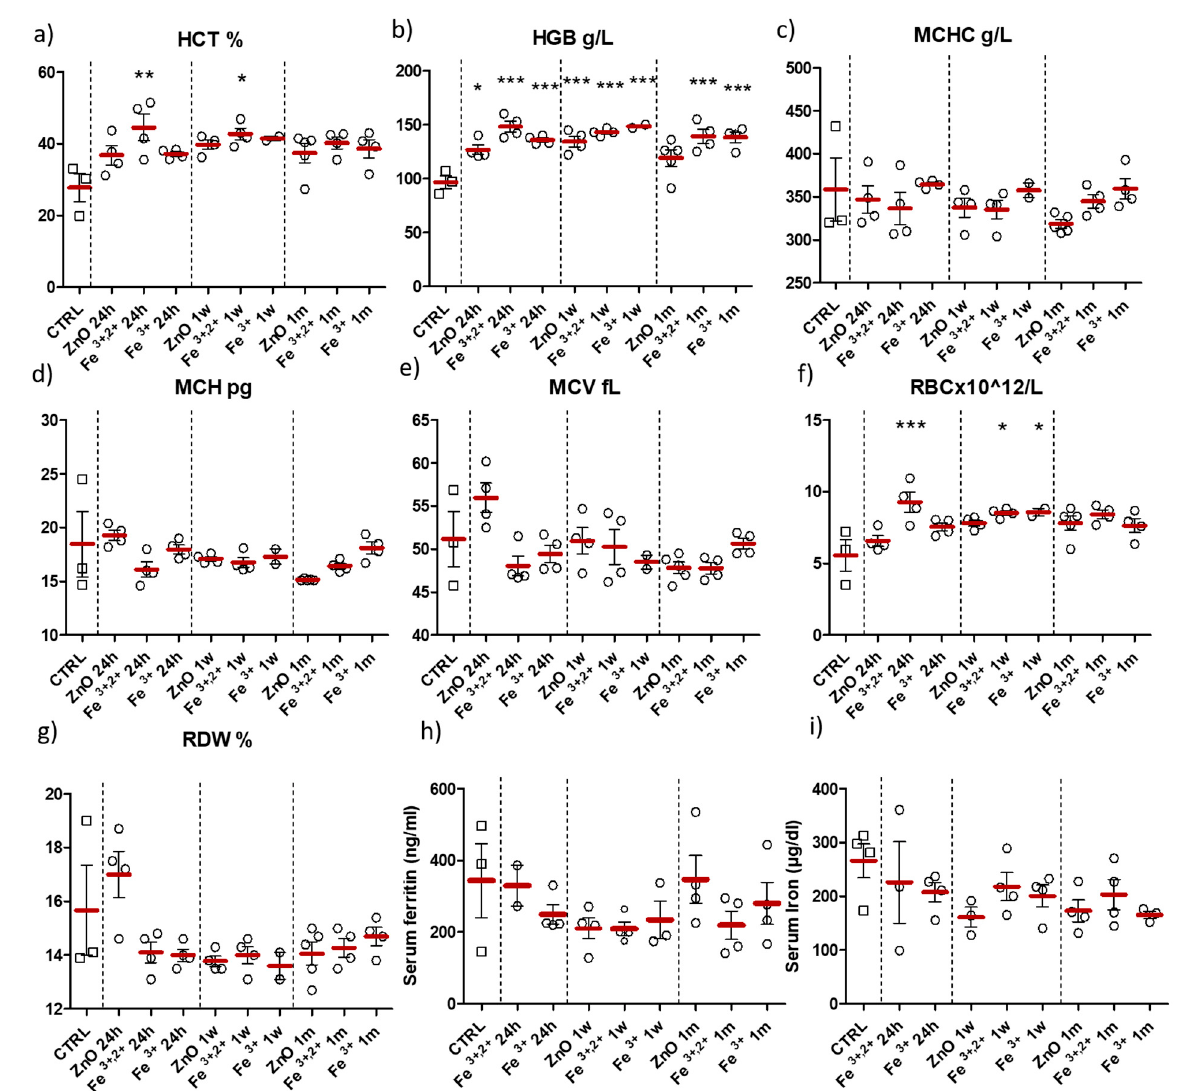
Figure 8. Hematological parameters, serum ferritin and iron levels in analyzed blood samples after intra-gastric administration (gavage) of ZnO, ZnO:Fe 3+ or ZnO:Fe 3+,2+ nanoparticle suspension in RO water vs. the control group (CTRL). Animals were sacrificed following 24 h, 1 week (1 w) or 1 month (1 m) after nanoparticle application. Hematocrit-HCT ( a ), hemoglobin concentration-HGB ( b ), mean corpuscular hemoglobin concentration-MCHC ( c ), mean corpuscular hemoglobin-MCH ( d ), mean corpuscular volume-MCV ( e ), erythrocyte count-RBC ( f ), red cell distribution width-RDW ( g ), serum ferritin ( h ) and iron ( i ) levels were measured in mice blood. Data presented as mean (±SEM) for control ( n = 3 for a – h / n = 4 for i ) vs. experimental groups (ZnO 24 h n = 4; Fe 3+,2+ 24 h n = 4; Fe 3+ 24 h n = 4; ZnO 1 w n = 4; Fe 3+,2+ 1 w n = 4; Fe 3+ 1 w n = 2–4; ZnO 1 m n = 5; Fe 3+,2+ 1 m n = 4; Fe 3+ 1 m n = 4). Statistically significant differences of * p ≤ 0.05, ** p ≤ 0.01, and *** p ≤ 0.001 were accordingly indicated. Range presented as squares for CTRL and circles for experimental groups.